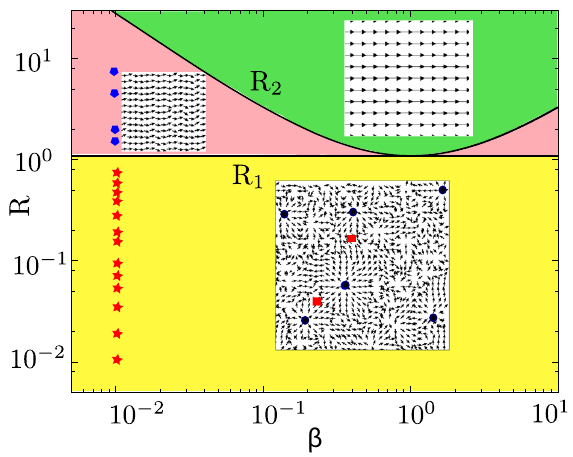
FIG. 1. R - β phase diagram of a polar active suspension. The lines at R ¼ R 1 and R ¼ R 2 , obtained from linear stability analysis, mark the phase boundaries. For R < R 1 , an aligned state is O ð q Þ unstable, which leads to statistically stationary defect turbulence. In general, a parameter range ( R 1 < R < R 2 Þ where perturbations with small wave number q grow at a rate of O ð q 2 Þ intervenes between the stable regime ( R > R 2 ) and the highly unstable regime of O ð q Þ growth but is squeezed out of existence if β ¼ 1 ; that is, orientation and vorticity have identical diffusivities. The red stars and blue pentagons mark the ( R , β ) values used in our DNS. Insets: order parameter vector field for defect turbulence ( R < R 1 ) with asters (blue dot) and saddles (red square), phase turbulence with orientational order ( R 1 < R < R 2 ), and a quiescent linearly stable state of complete alignment ( R > R 2